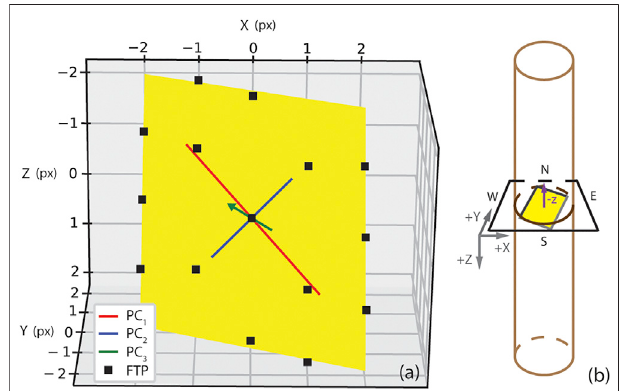
FIGURE 3 | (A) 3D example of a plane fi tted to a cloud of FTPs by principal component analysis (PCA) and (B) the reference system applied for each slice (black) of the 3D image of the rock core (brown). The 3 axes of the fi rst (red), second (blue) and third (green) principal component vectors are shown in the left image. The normal of the plane is the green vector (PC 3